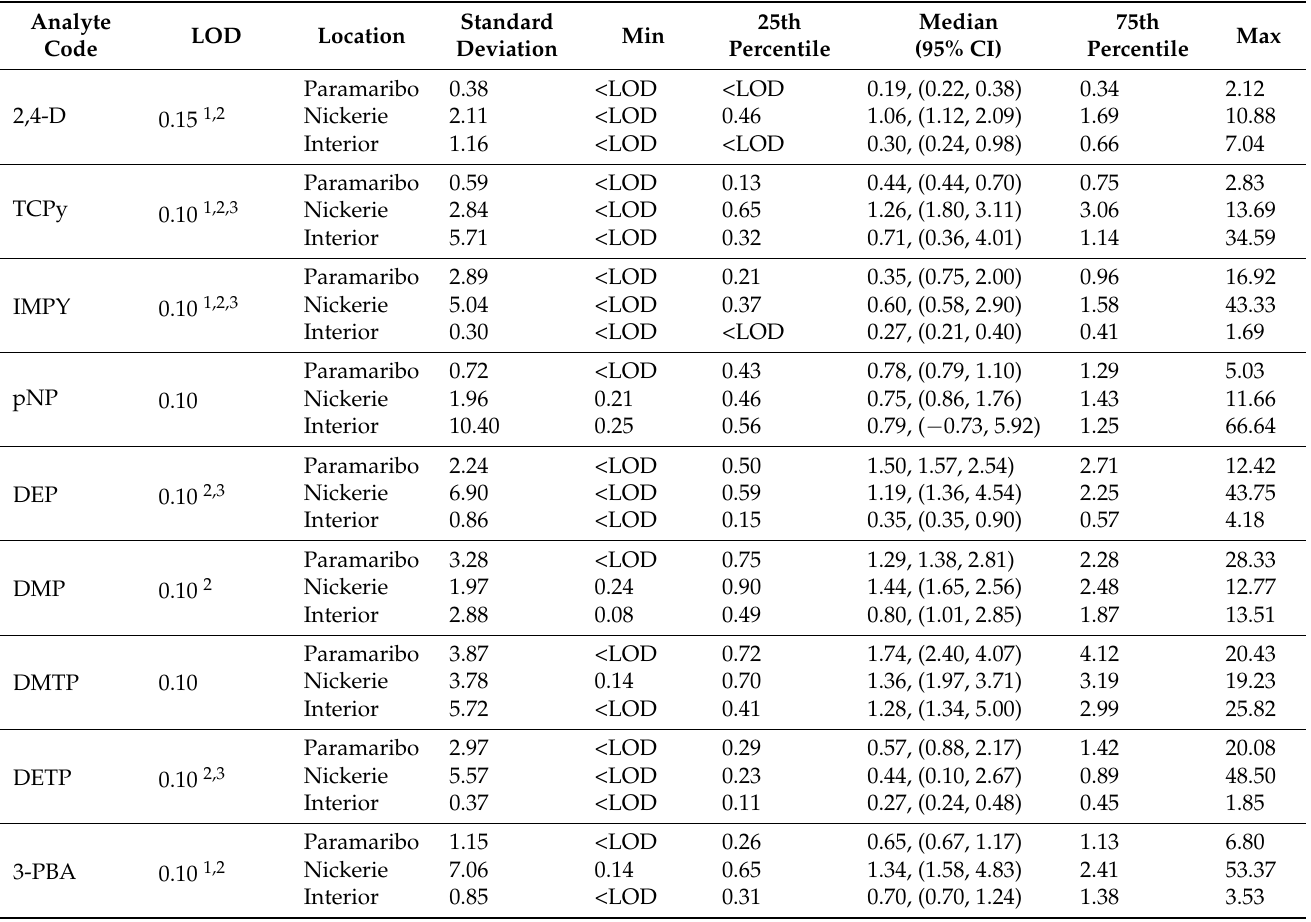
Table 3. Specific gravity adjusted urinary pesticide and metabolite concentrations ( µ g/L) in pregnant women in Suriname by location, n =